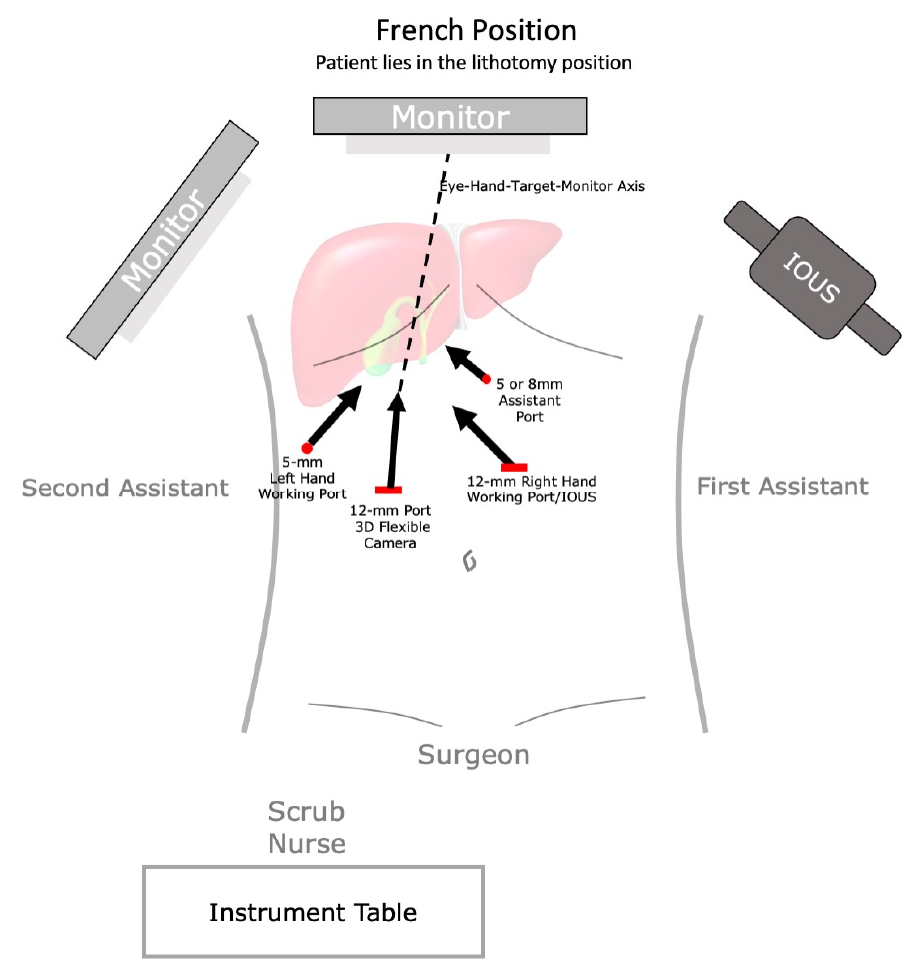
Figure 4. Operating room set-up and scheme of port positioning in laparoscopic OER. IOUS, intraoperative ultrasound.